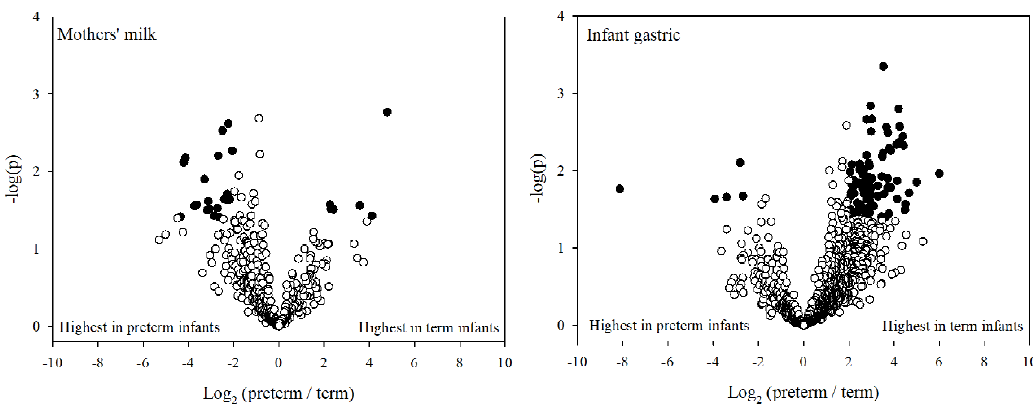
Figure 5. Volcano plots depicting fold change in individual peptide intensity ( x- axis, logarithmic) and p- value ( y -axis, logarithmic) between term and preterm infant milk and gastric samples. Filled circles indicate the peptide was significantly different between preterm and term infants ( p < 0.05), whereas the hollow circles are non-significant.